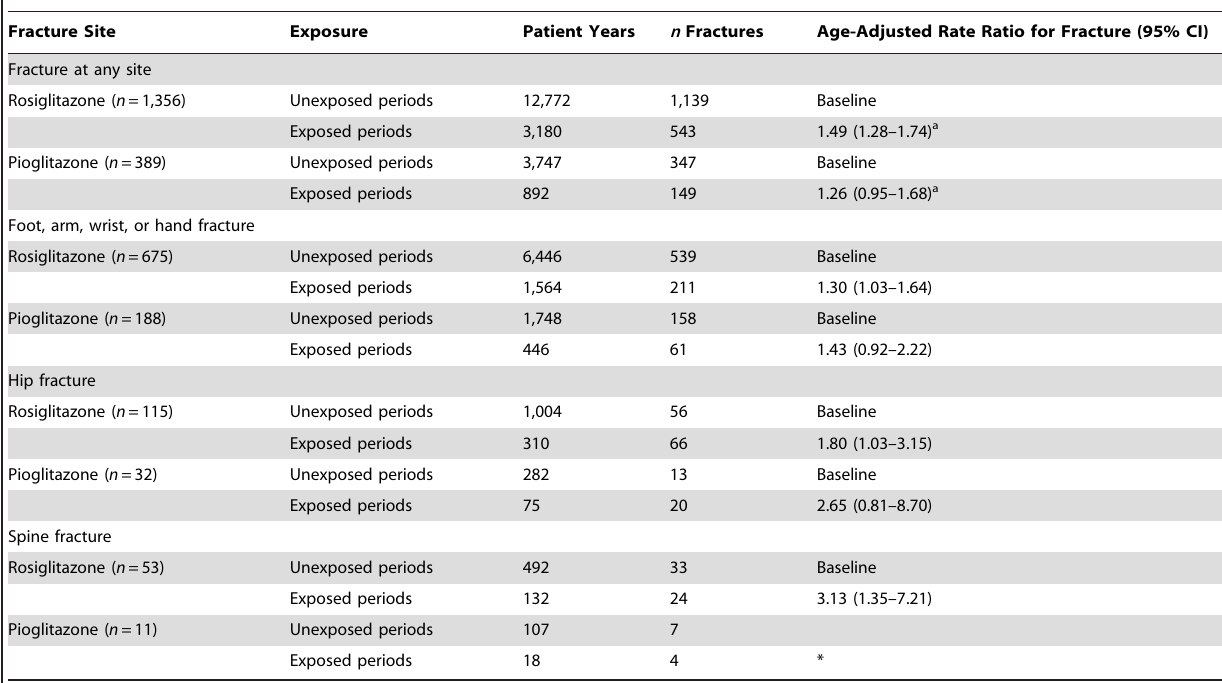
Table 3. Case-series analysis for thiazolidinediones: association between exposure to specific thiazolidinediones and fractures.